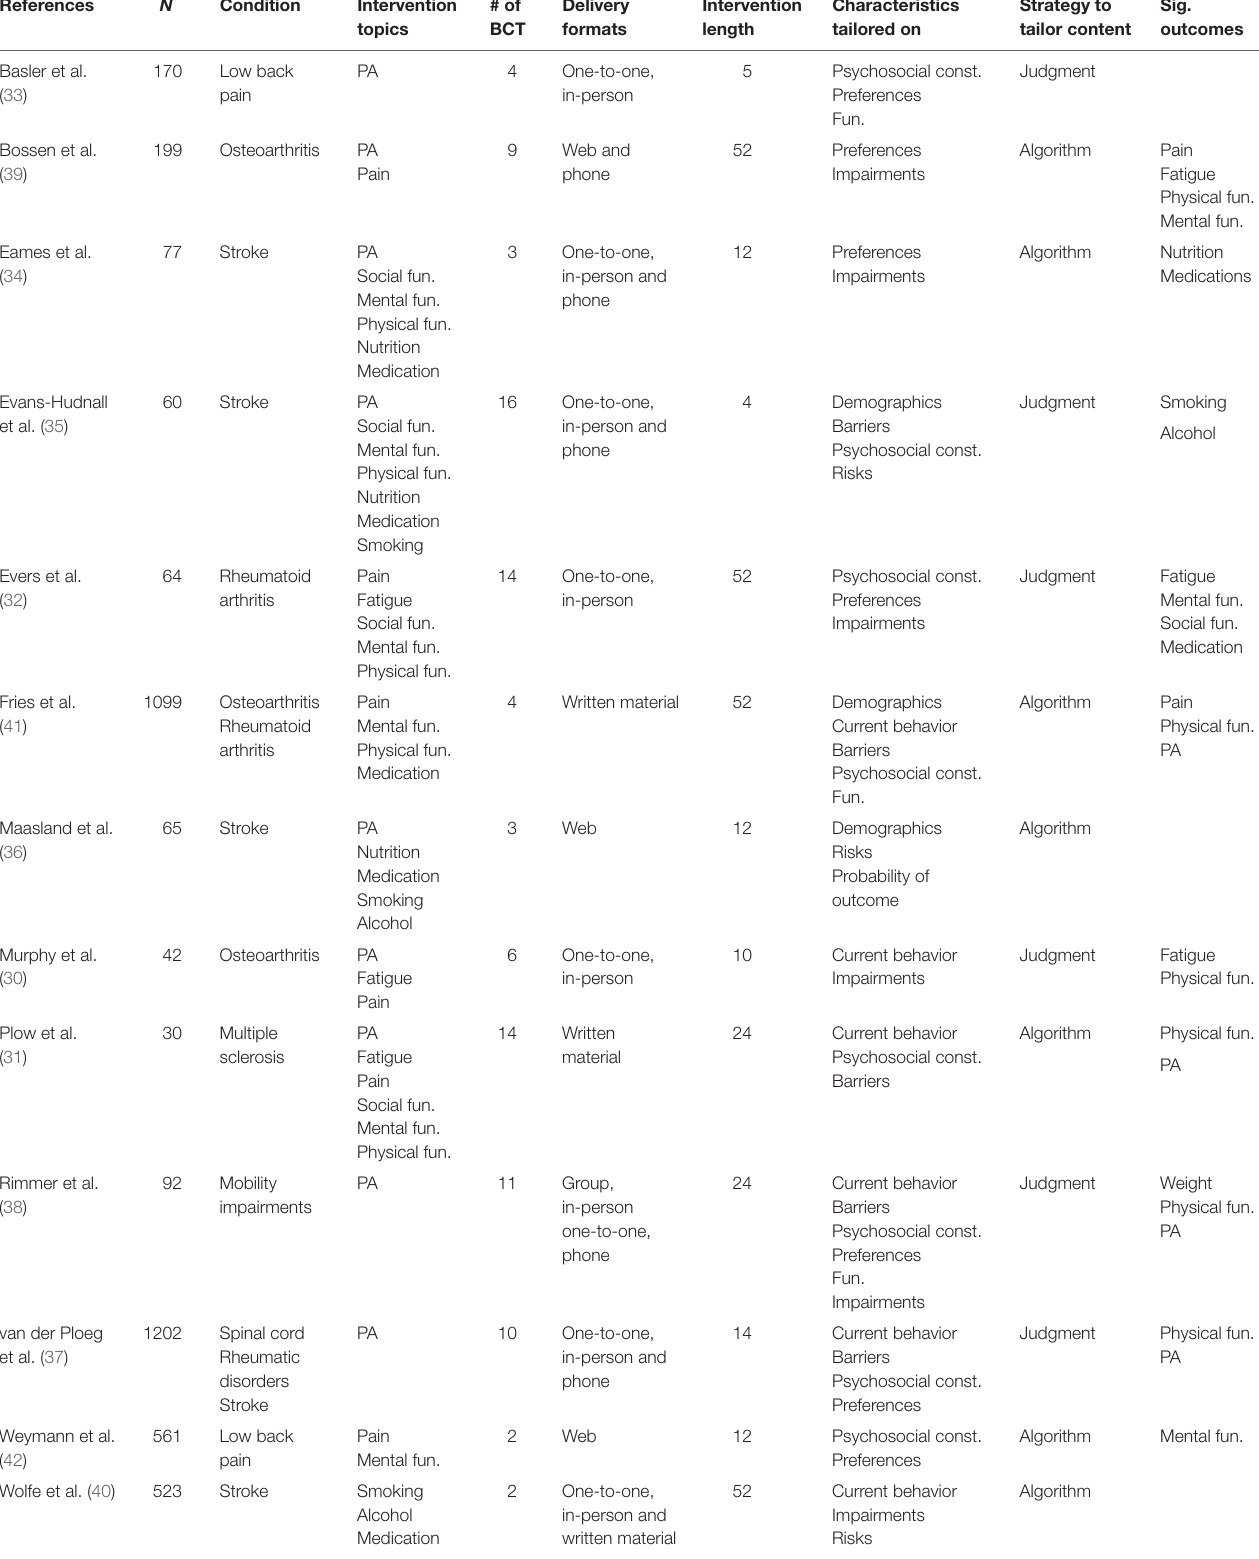
TABLe 2 | Research design, outcomes, and description of